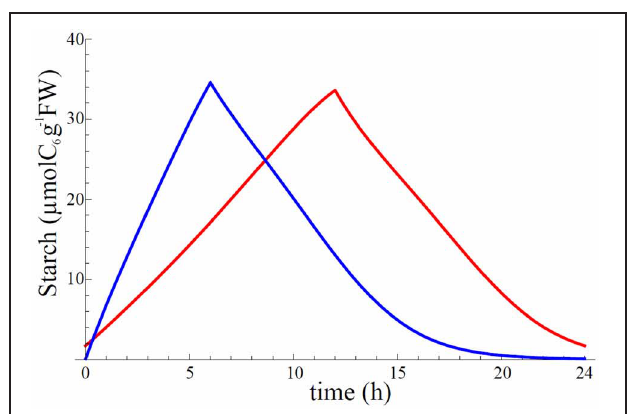
FIGURE A4 | Estimated point values for γ at each sample data from Figure 2A from Gibon et al. (2004) using oscillating β ( t ) . The curve is the result of fitting a cosine to the estimation points of γ . From the fitting we obtain a γ = 0 . 75, b γ = 0, and φ γ = 7 . 8.